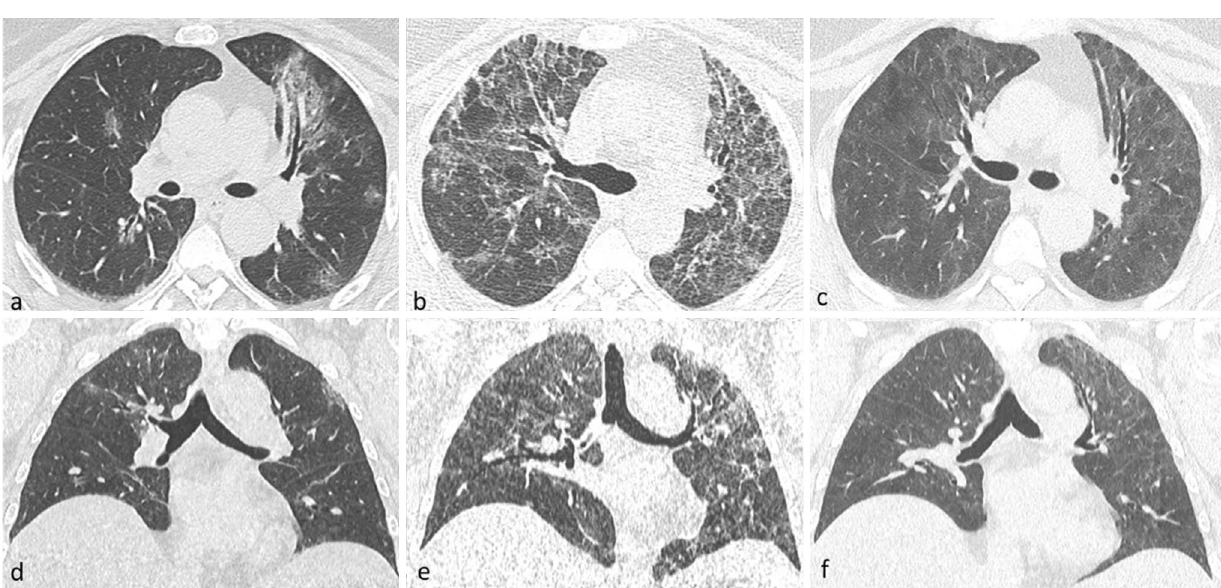
Figure 2. Graphic representation of patients’ follow-up, including the number of patients with different degrees of baseline parenchymal extension and patients with or without residual abnormalities at the two follow-up timepoints.